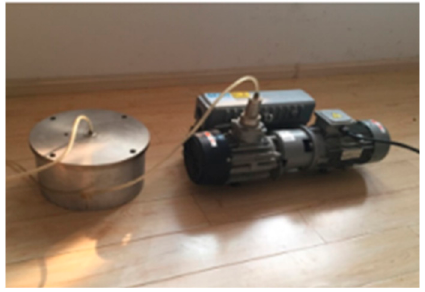
Figure 4. The device for pumping vacuum.